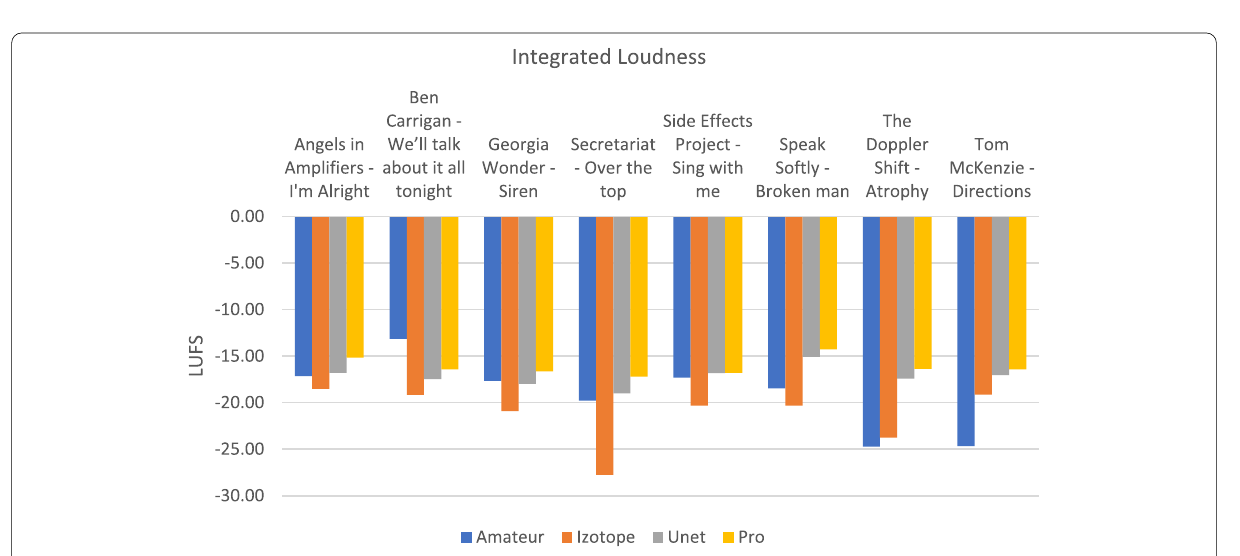
Fig. 5 Integrated loudness calculated for all music samples in LUFS (loudness unit full